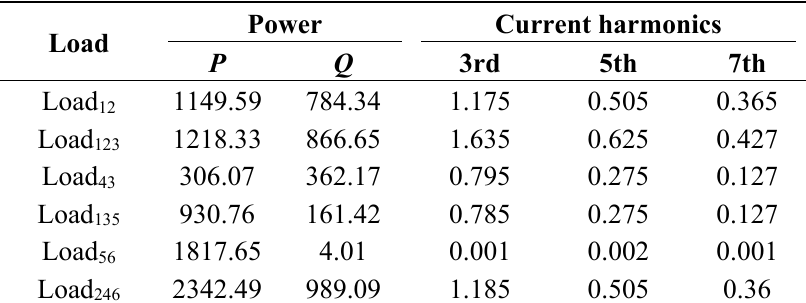
Table 7. Appliances aggregated